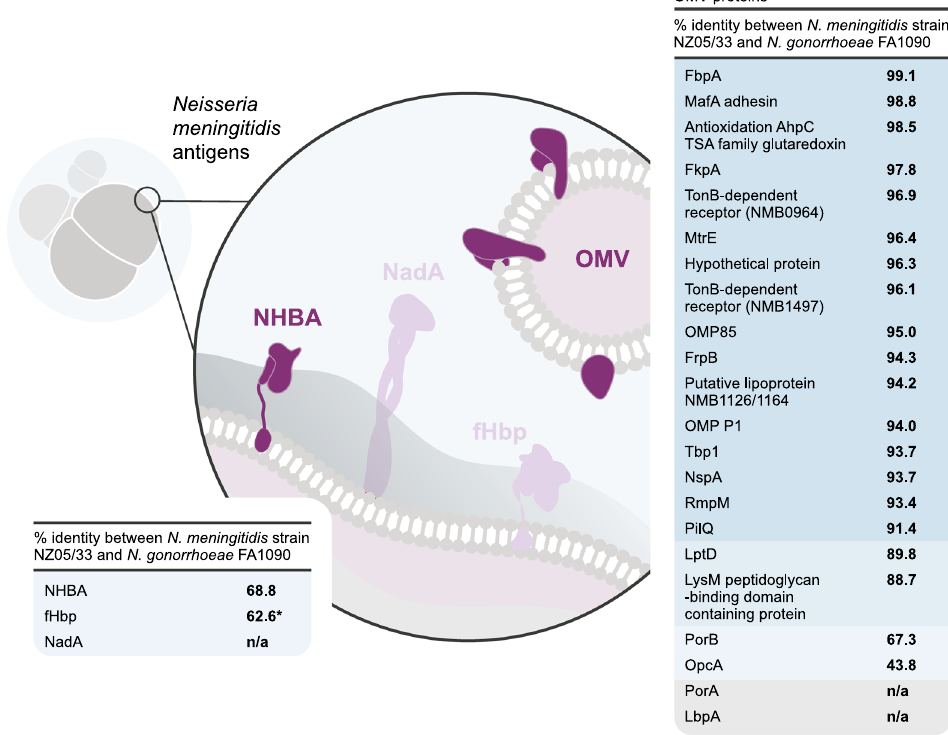
Fig. 2 Main components of the 4CMenB vaccine and sequence similarity to gonococcal homologs (table adapted from Semchenko et al. 30 ). NHBA neisserial heparin binding antigen, NadA Neisseria adhesin A, fHbp factor H binding protein, OMV outer membrane vesicle, FbpA ferric binding protein A, MafA multiple adhesin family A, AhpC alkyl hydroperoxide reductase C, TSA thiol-speci fi c antioxidant, FkpA FKBP-type peptidyl-prolyl cis-trans isomerase, NMB Neisseria meningitidis strain MC58, MtrE outer membrane ef fl ux protein, OMP outer membrane protein, FrpB Fe-regulated protein B, Tbp1 transferrin binding protein 1, NspA Neisseria gonorrhoeae surface protein A, RmpM reduction modi fi able protein M, PilQ pili-associated protein Q, LptD lipopolysaccharide-assembly protein, LysM lysin motif, PorB porin, major OMP PIB, OpcA opacity protein A, PorA porin, serosubtype P1.4, LbpA lactoferrin binding protein A, n/a not available. *The gonococcal fHbp is not surface